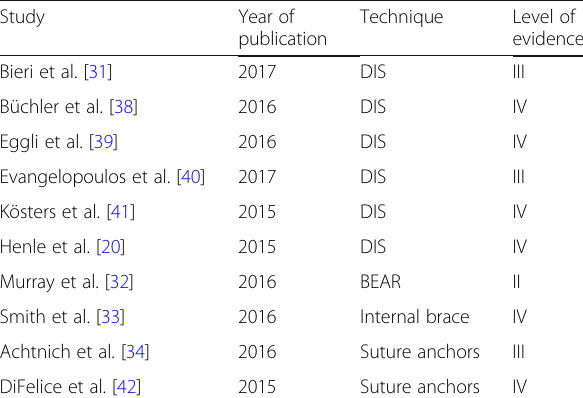
Table 1 Clinical studies: level of evidence and the type of the implant